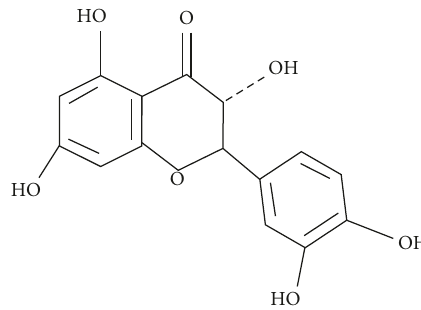
Figure 7: Chemical structure of taxifolin.